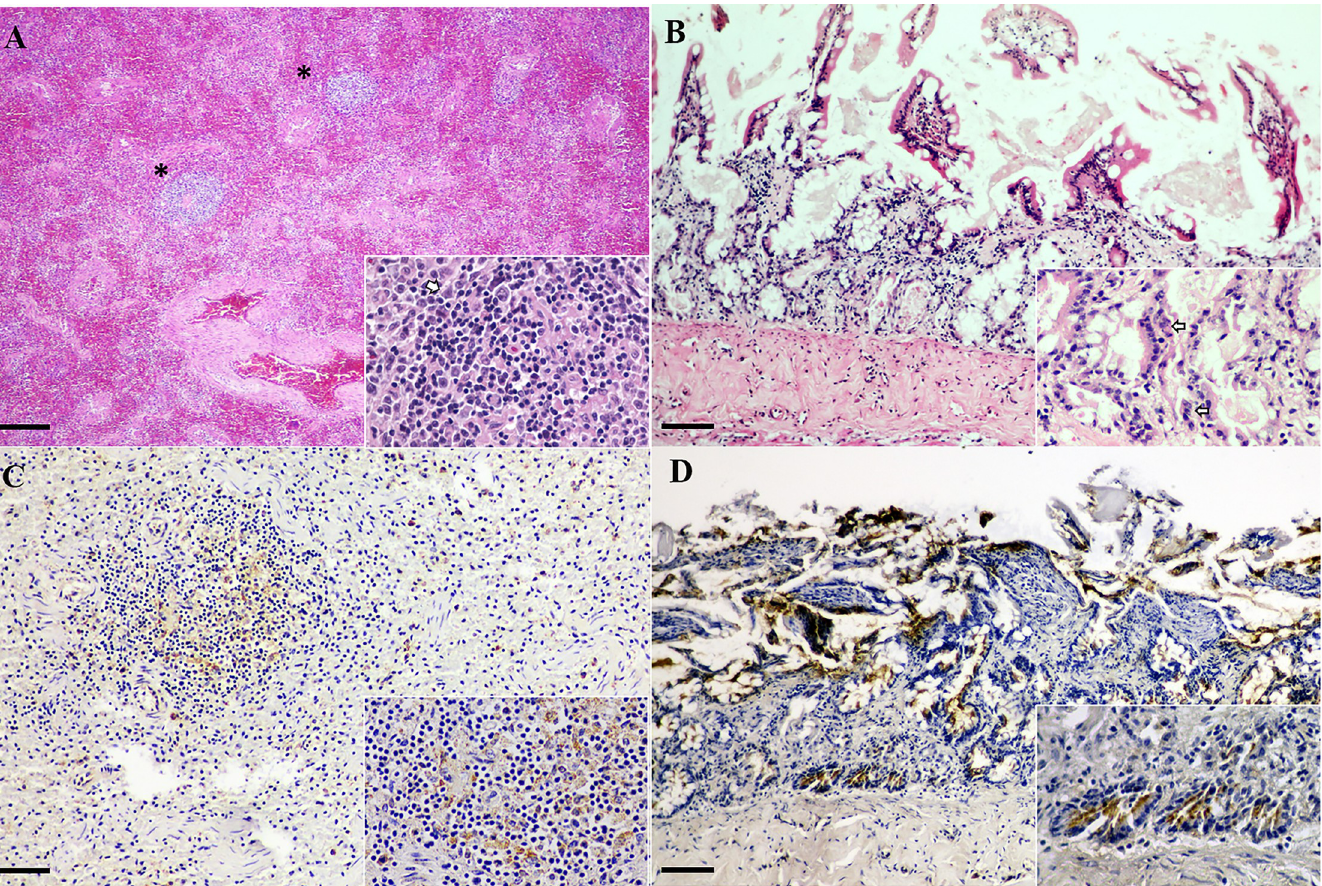
Fig 1. CPPV-1 infection in fishing cats. Demonstrative H&E (A, C) and CPPV-1 IHC (B, D) pictures from fishing cats. (A) Fishing cat no. 1. Diffuse congested spleen with sparse numbers of lymphoid follicles. Center of one of the remaining lymphoid follicles contained eosinophilic fibrillar material (fibrin) intermixed with scattered karyorrhectic debris of lymphocytes (lymphocytolysis) (inset). Few numbers of these lymphocytes contained 5–7 μ m basophilic intranuclear inclusion bodies that marginated the nuclear chromatin (arrow). (B) Fishing cat no. 3. Shortening of villi with occasional dilated crypts that contained eosinophilic proteinaceous substances and lined by markedly attenuated or necrotic crypt epithelial cells (inset). Many crypt epithelial cells were pyknotic and karyorrhectic and rare cells contained similar basophilic intranuclear inclusion bodies (arrows). (C) Fishing cat no. 1. The CPPV-1 immunoreactivity was frequently observed in the cytoplasm of mononuclear cells in the area of splenic lymphoid follicle. (D) Fishing cat no. 3. CPPV-1 IHC signals were diffusely detected and the immunoreactivity signals were markedly localized in the cytoplasm of cryptal epithelial cells (inset). Bars indicate 25 μ m for (A) and 120 μ m for (B–D).